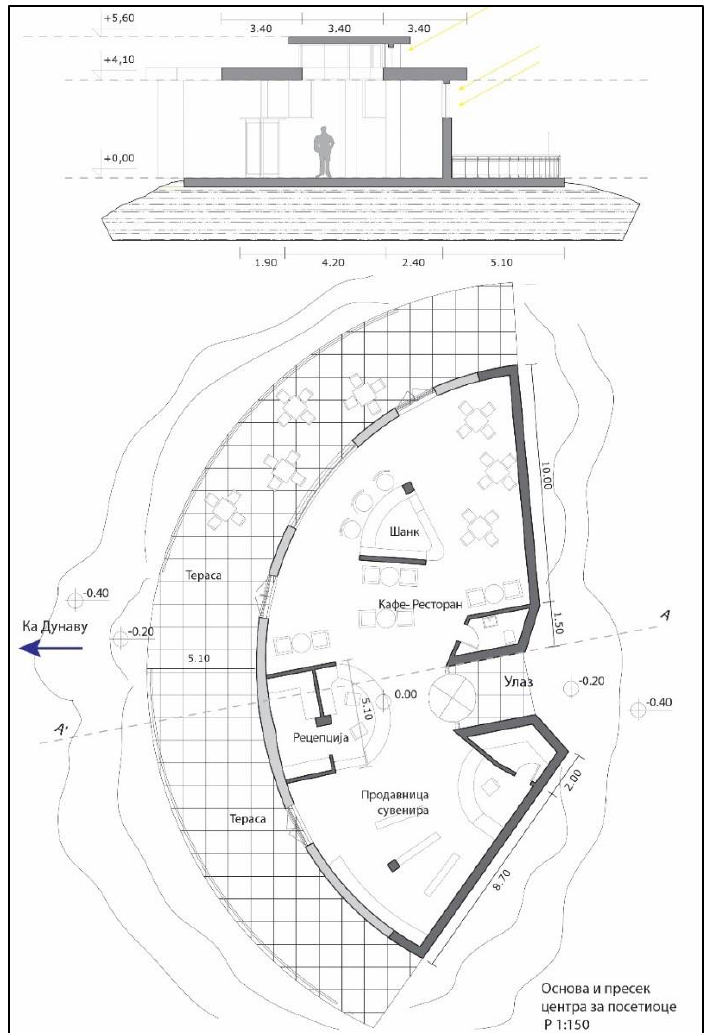
Figure 38. Basis and cross-section of the Visitors Centre, a simple and effective form, reminding a clover leaf. Lepenski Vir, Serbia (2019) by ArhiArhi (Predrag, Vladimir and Grigor Milošević)